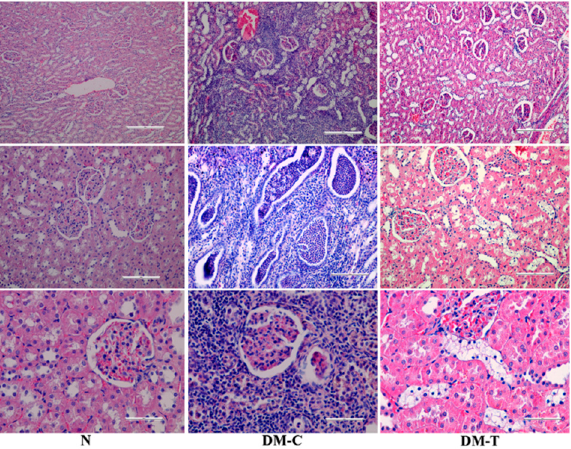
Figure 5. Histopathologic examination of kidney in N, DM-C, and DM-T rats. Histopathological observations in spleen from Figure 6: